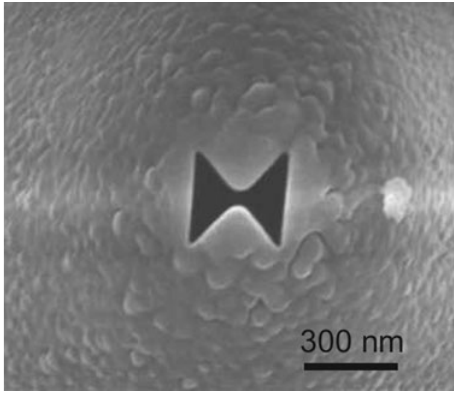
Figure 3 Bowtie-shaped nanoaperture at a fi ber probe